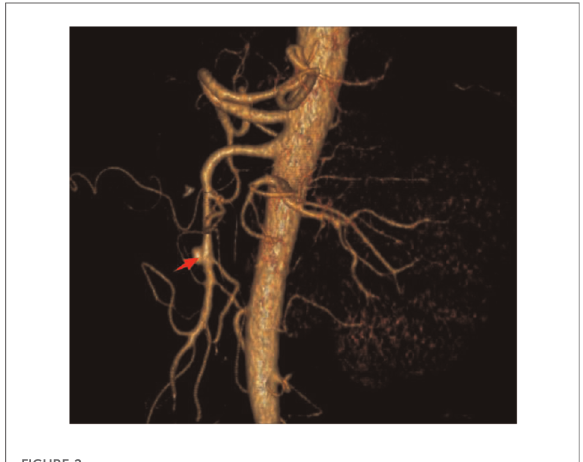
FIGURE 2 Comparison of true lumen stenosis rate between conservative treatment group and endoluminal treatment